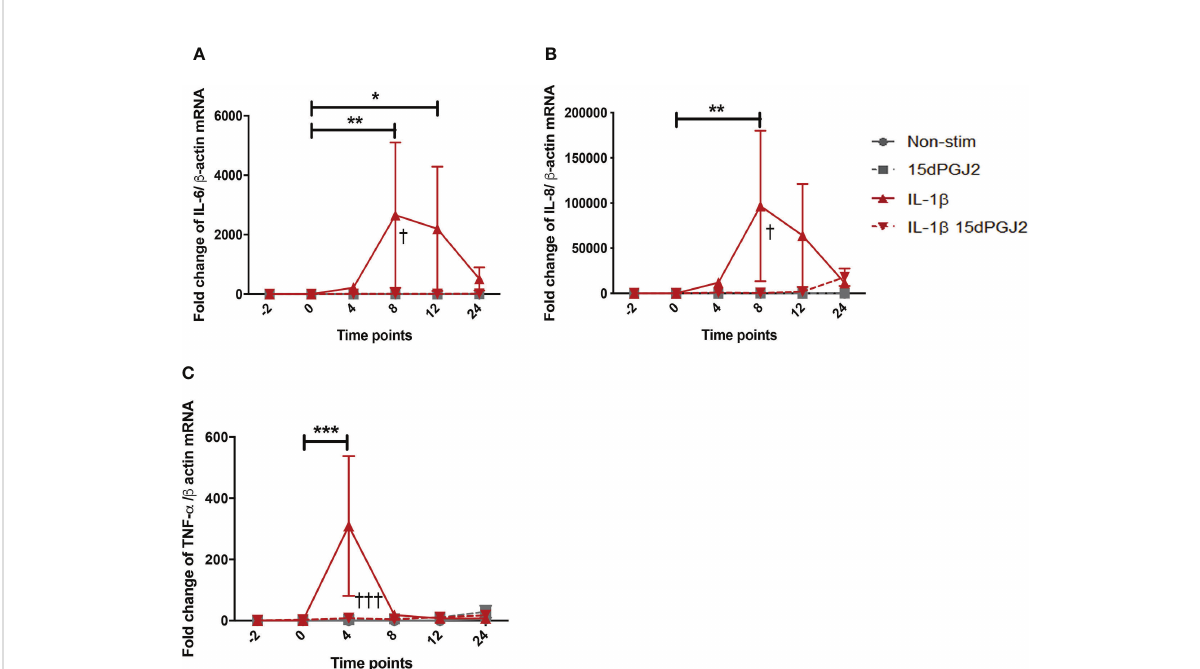
FIGURE 2 15dPGJ2 inhibits IL-1 b -induced IL-6, IL-8, and TNF- a cytokines mRNA production in myometrial cells. Myometrial cells were pre-incubated for 2 hours with 32µM 15dPGJ2 or vehicle prior to 1ng/ml of IL-1 b stimulation. Cells were harvested at -2, 0, 4, 8, 12 and 24 hours post IL-1 b stimulation. Quantitative RT-qPCR was used to determine the effect of 15dPGJ2 on IL-6, IL-8, and TNF- a mRNA. Fold change took into account the reference gene b actin. A signi fi cant increase in IL-6 was observed with IL-1 b at 8 and 12 hours (p < 0.01, p < 0.05), and inhibition of this effect was seen when cells were pre-incubated with 15dPGJ2 at 8 hours (p < 0.05) (A) . A signi fi cant increase in IL-8 was seen at 8 hours (p < 0.01), and inhibition of this effect was seen when cells were pre-incubated with 15dPGJ2 at 8 hours (p < 0.05) (B) . TNF- a mRNA